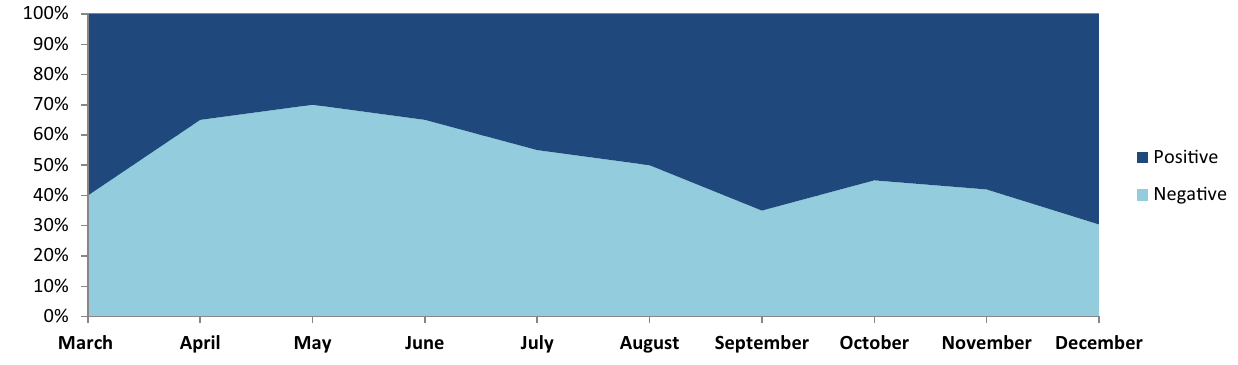
Figure 7. Public opinion analysis on lowdown discussed during the pandemic period.